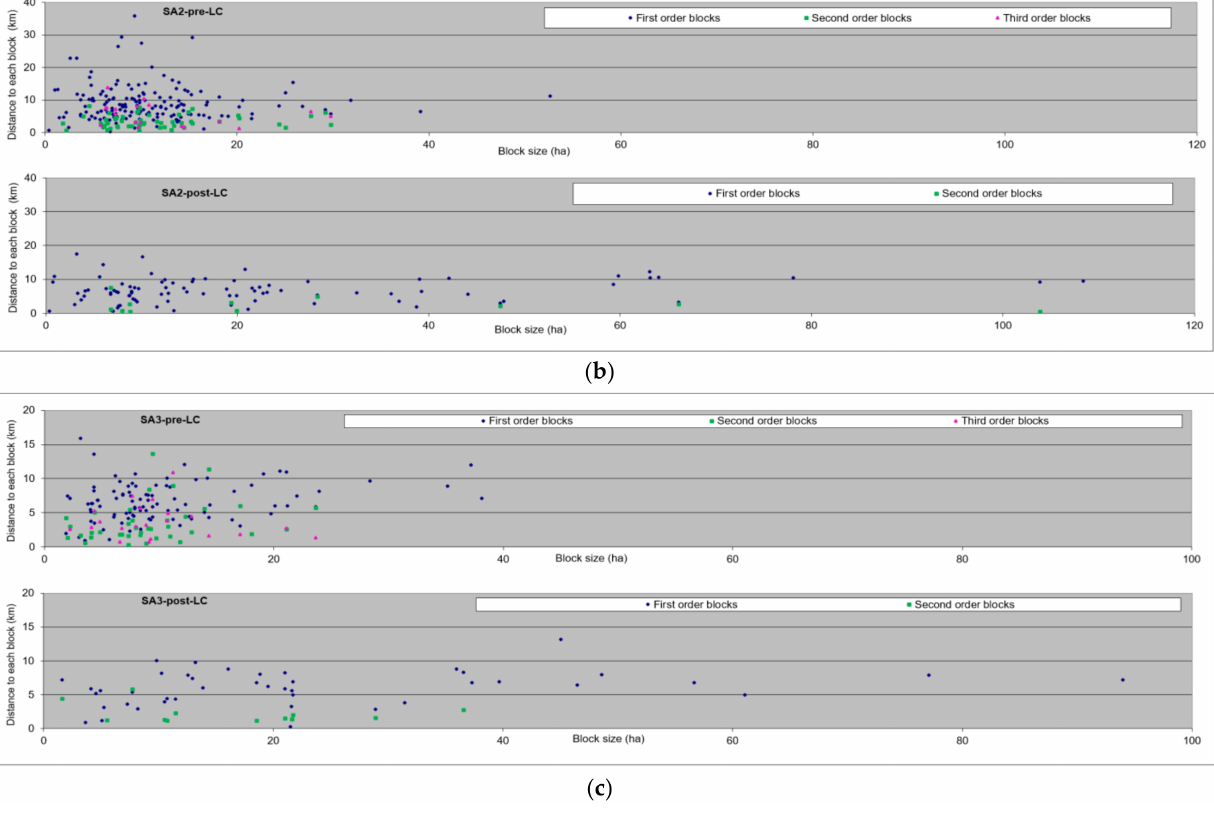
Figure 3. Variation of the typology, size, and spatial scattering of the blocks (pre and post-LC) SA1